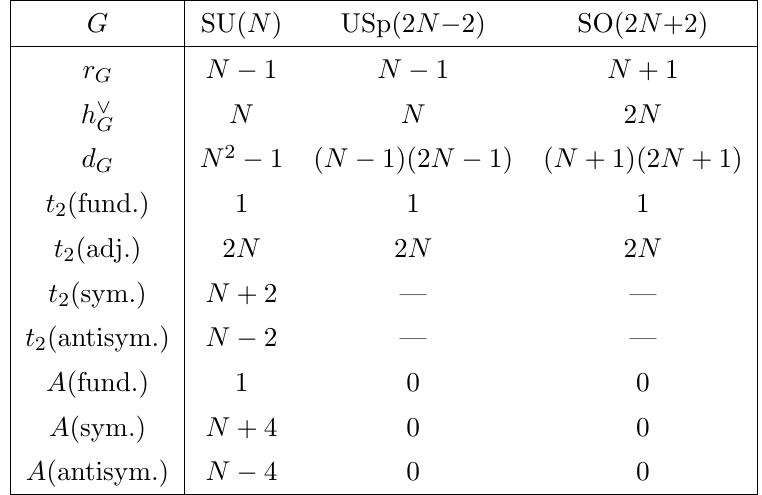
Table 3 . Group theoretical constants. Here, r G denotes for the rank, d G is the dimension of G , and h _ is the dual Coxeter number. For a given representation of a group G , t 2 (rep : ) denotes G the second Dynkin index, while A (rep : ) is the cubic anomaly coe(cid:14)cient. The conventions for the second Dynkin index of SU and USp groups are adjusted to be the same as that of SO groups by multiplying an additional factor of